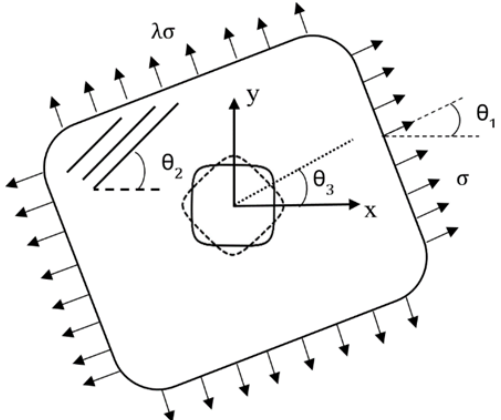
Figure 1. Infinite perforated orthotropic plate subject to biaxial loading ( θ 1 is load angle, θ 2 is fiber angle, and θ 3 is cut out